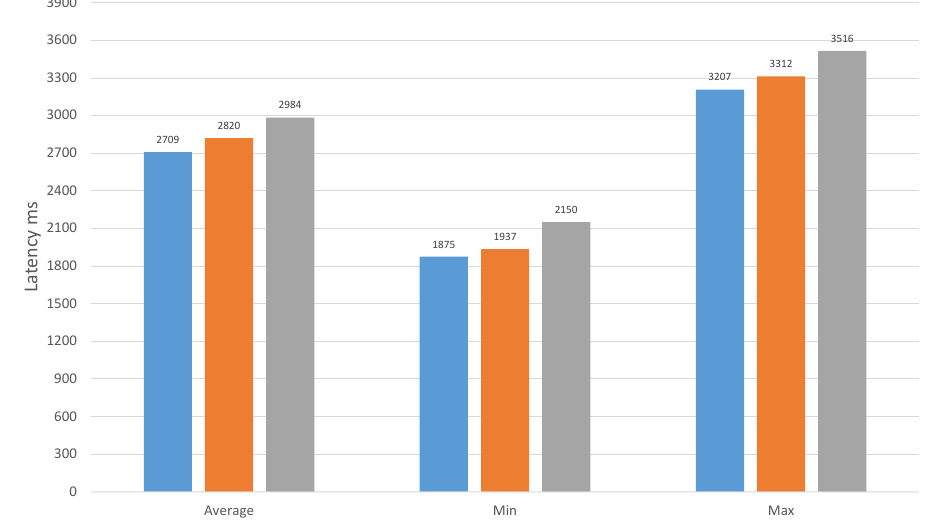
Figure 15. Latency in invoke transaction.